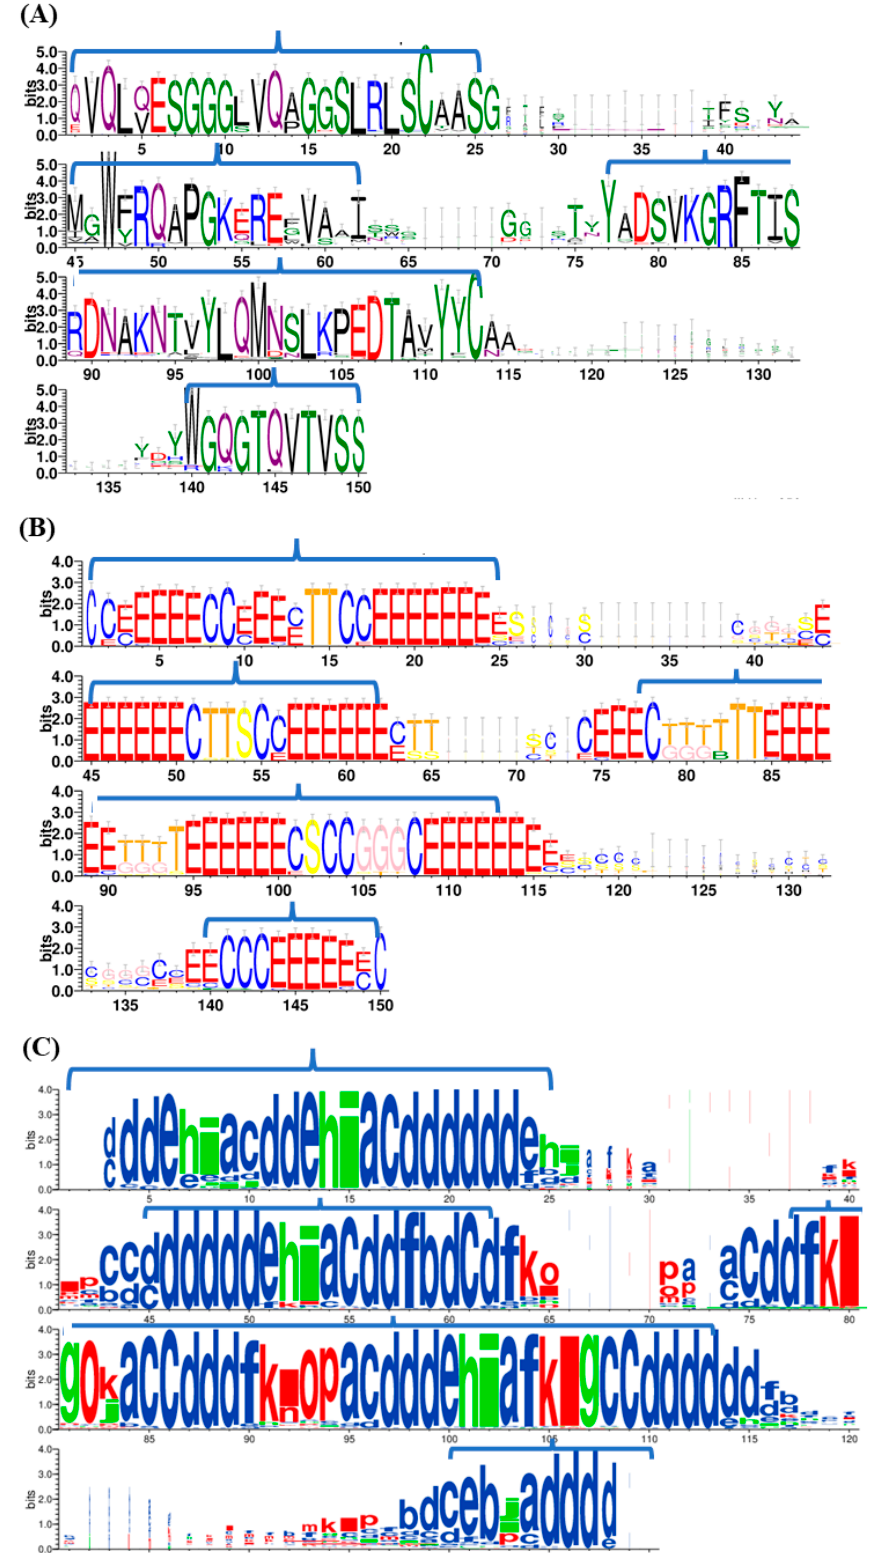
Figure 1. Sequence and structure characteristics in V H H dataset. Conservation of ( A ) amino acid residues, ( B ) secondary structures and ( C ) Protein Blocks. The four Framework regions are delineated in each figure.